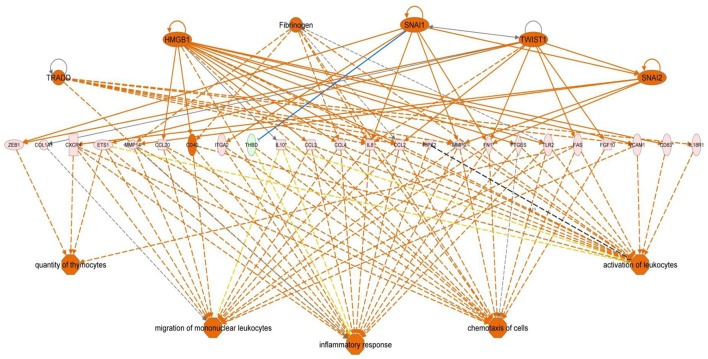
Regulator effector network of genes differentially expressed in the posterior intestine of European sea bass. It integrates the upstream regulators (upper line), differentially expressed genes (middle line), and downstream effects results (lower line).